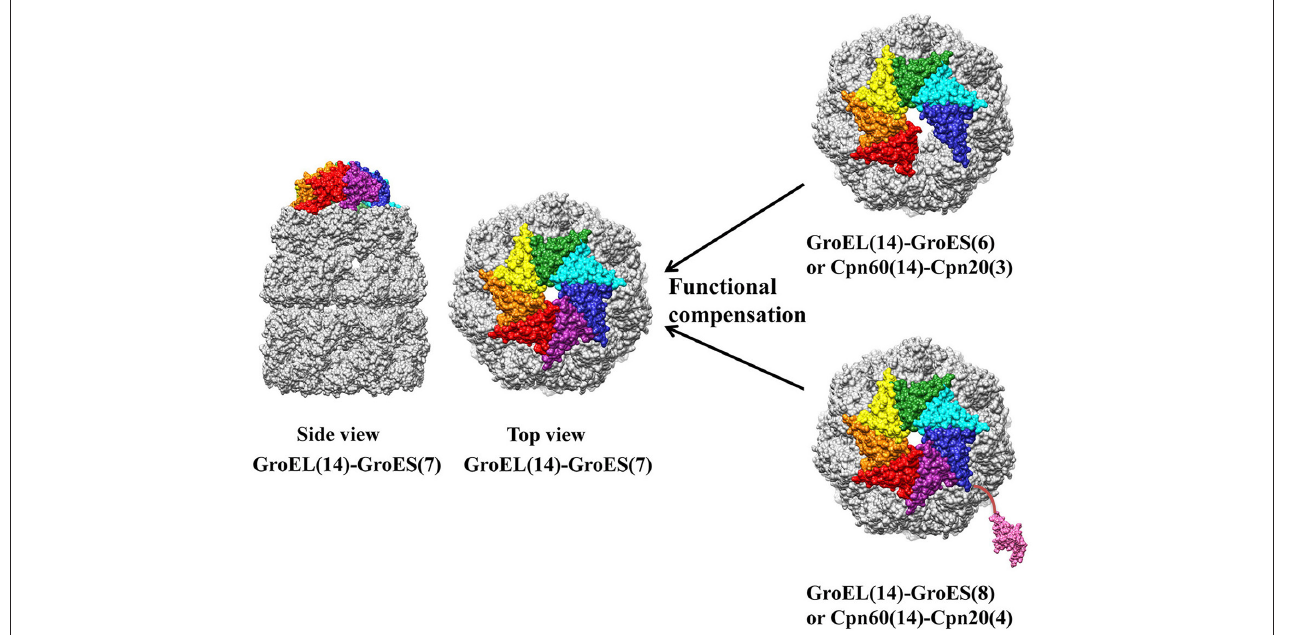
FIGURE 5 | Asymmetric functional interaction between chloroplast chaperonin and co-chaperonin. GroEL is colored in gold, and seven GroES subunits are colored in red, orange, yellow, green, cyan, blue, and pink. Co-chaperonins consisting of six or eight GroES like domains function equally as well as heptameric GroES. The molecular structure was generated by UCSF Chimera ( Pettersen et al., 2004) using GroES-GroEL-ADP coordinates 1AON from Protein Data